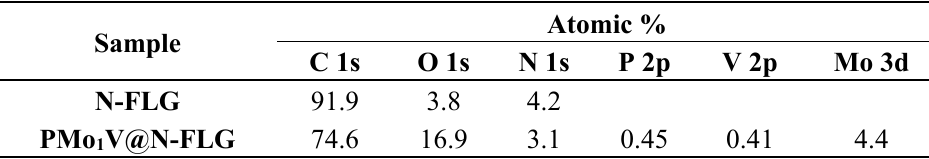
Table 1. XPS surface atomic percentages for N-FLG and PMo 11 V@N-FLG a .